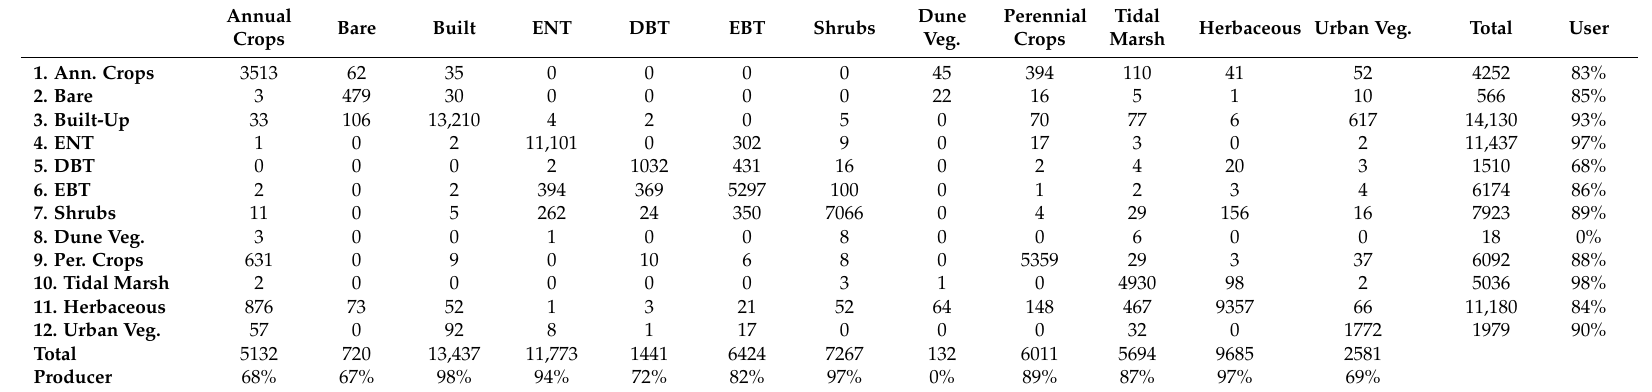
Table 3. CNN confusion matrix for the three-season classification.